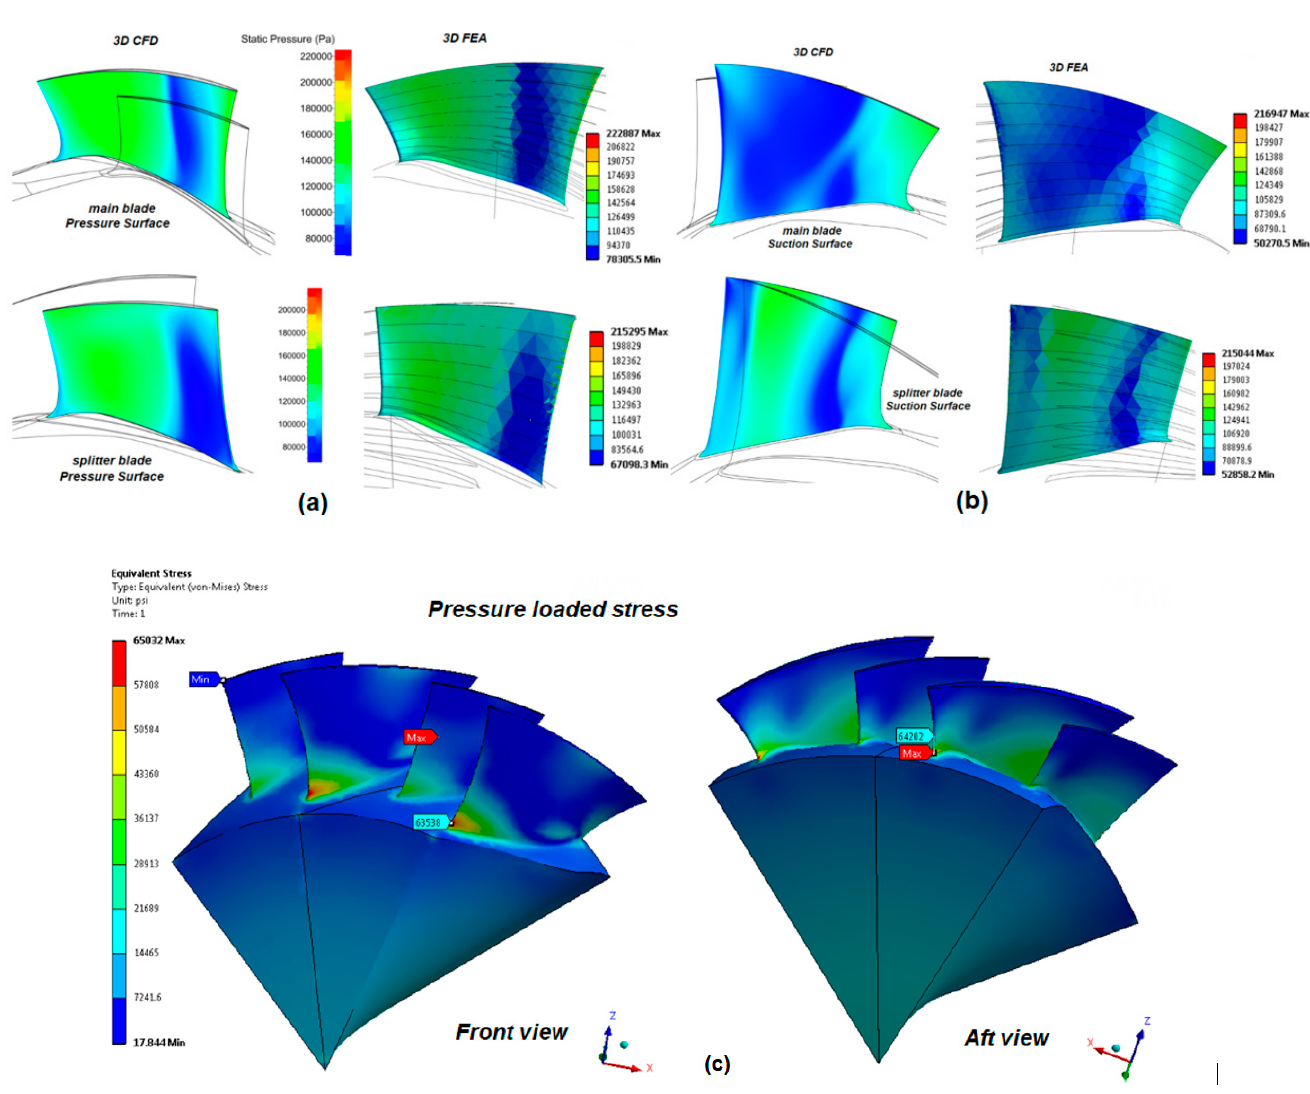
Figure 20. Pressure load mapped from 3D CFD to 3D CAD is shown in (a)-(b) and stress under load is shown in (c).